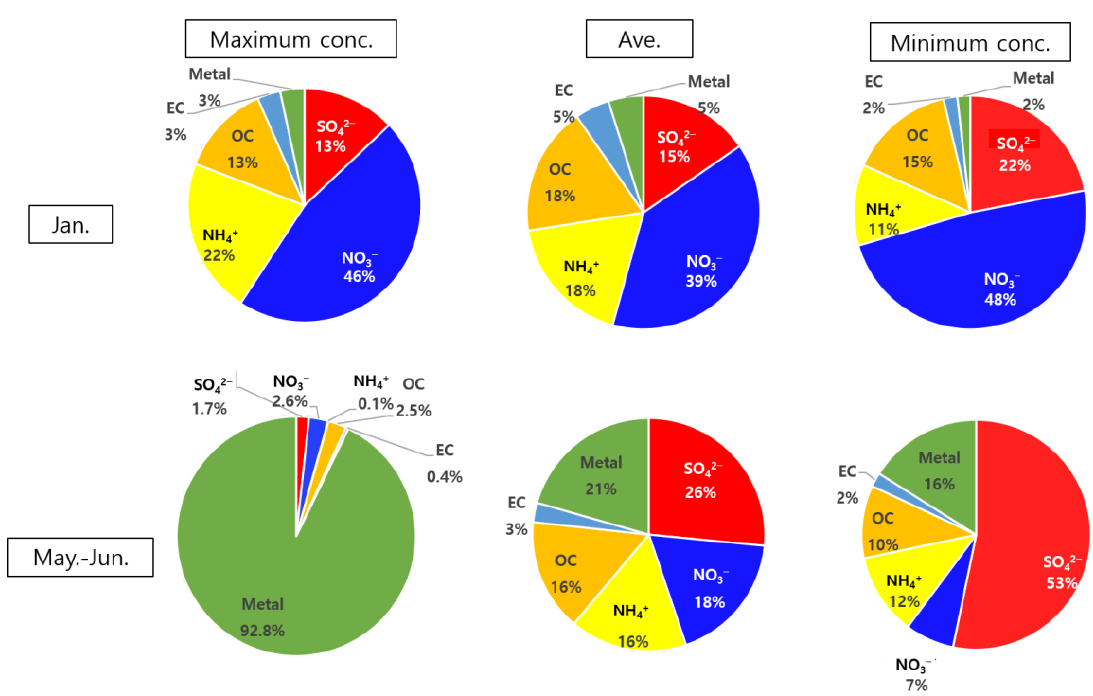
Figure 2. PM 2.5 chemical speciation during the measurement